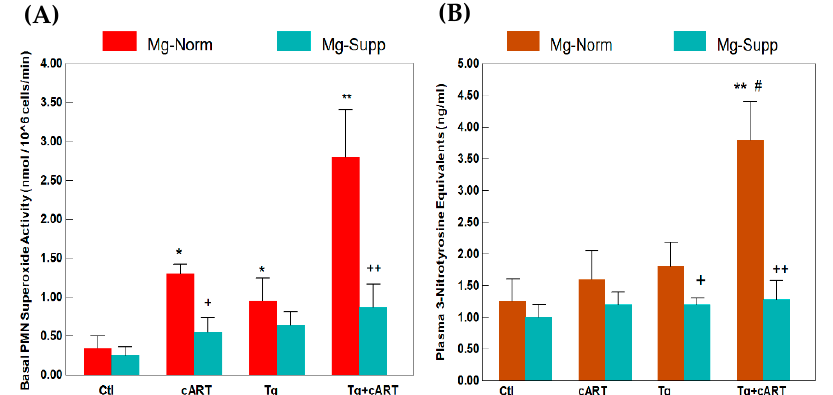
Figure 2. cART-enhanced basal superoxide production in circulating neutrophils ( A ), and elevated plasma 3-nitrotyrosine ( B ) in HIV-1 Tg rats receiving 18 weeks of cART treatment: Effect of Hi Mg diet. Values are means ± SE = 5 rats/group. * p < 0.05 and ** p < 0.01 vs. respective Ctl; # p < 0.05 vs. Mg-normal Tg alone. + p < 0.05 and ++ p < 0.01 vs. Mg-normal counterparts .